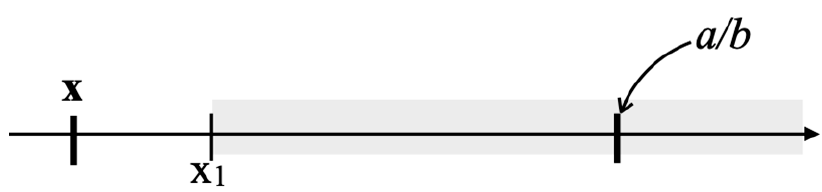
Figure 11. Pictorial representation of Case (2).